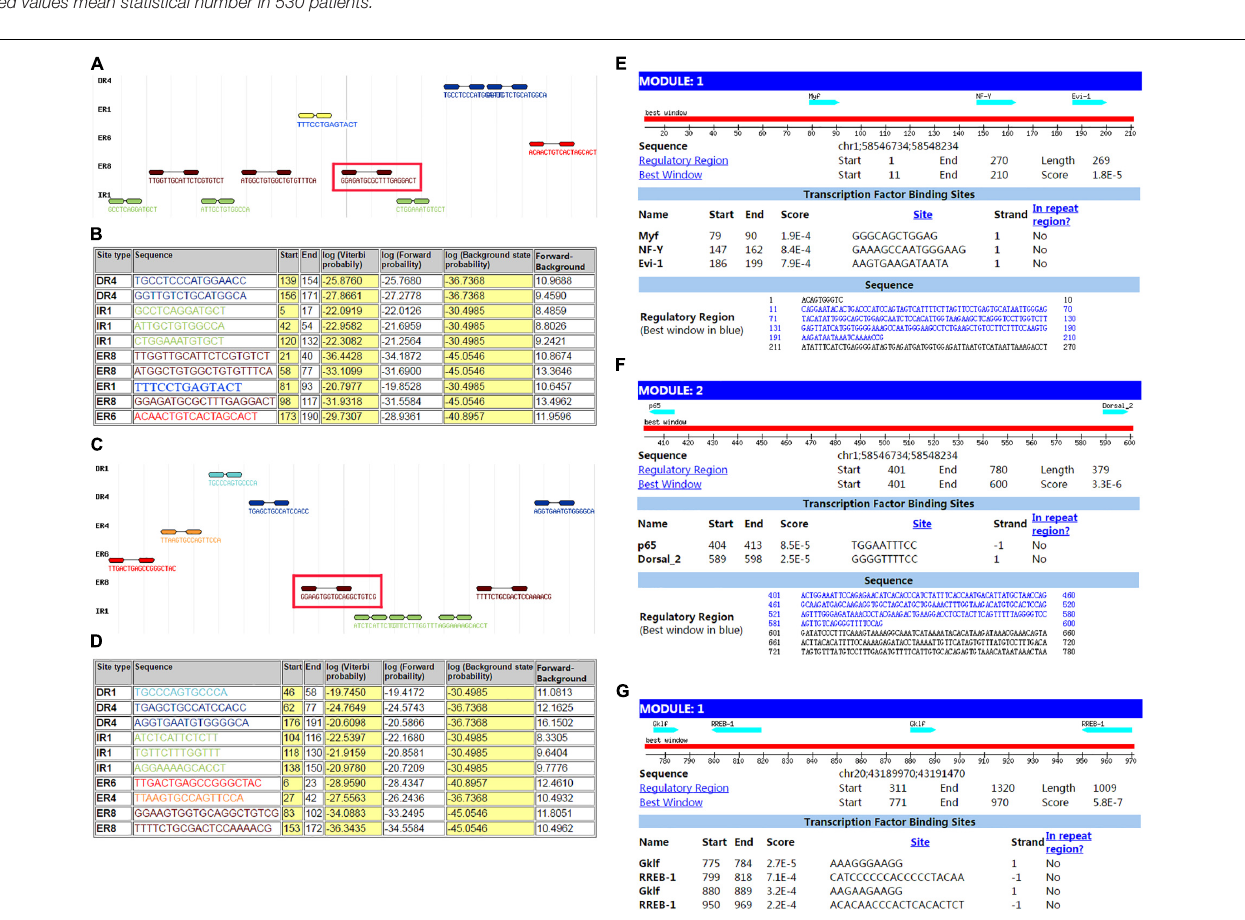
FIGURE 5 | Predicted transcription factor binding sites in DAB1 rs17115303 and PTPRT rs6030462. The sequences from 100 bp upstream to 100 bp downstream of DAB1 rs17115303 and PTPRT rs6030462 were analyzed using NHRscan software. (A) The sequence from 98 to 117 of DAB1 rs17115303 was predicted as the binding site fragment (ER8: GGAGATGCGCTTTGAGGACT; red box) with a mutation at base position 4. (C) The sequence from 83 to 102 of PTPRT rs6030462 was predicted as the binding site fragment (ER8: GGAAGTGGTGCAGGCTGTCG; red box), with a mutation at base position 19. (B,D) Statistical analysis of predicted binding sites of DAB1 rs17115303 (B) and PTPRT rs6030462 (D) . (E–G) Predicted transcription factor binding sites of DAB1 rs17115303 and PTPRT rs6030462 using NRHscan and Mscan software; transcription factor binding sites were predicted at 1,300–1,420 and 900–1,100 bp in the DAB1 rs17115303 binding site fragment (E,F) and at 725–531 bp in the PTPRT rs6030462 binding site fragment. The mutations in DAB1 rs17115303 and PTPRT rs6030462 were predicted to prevent transcription factor